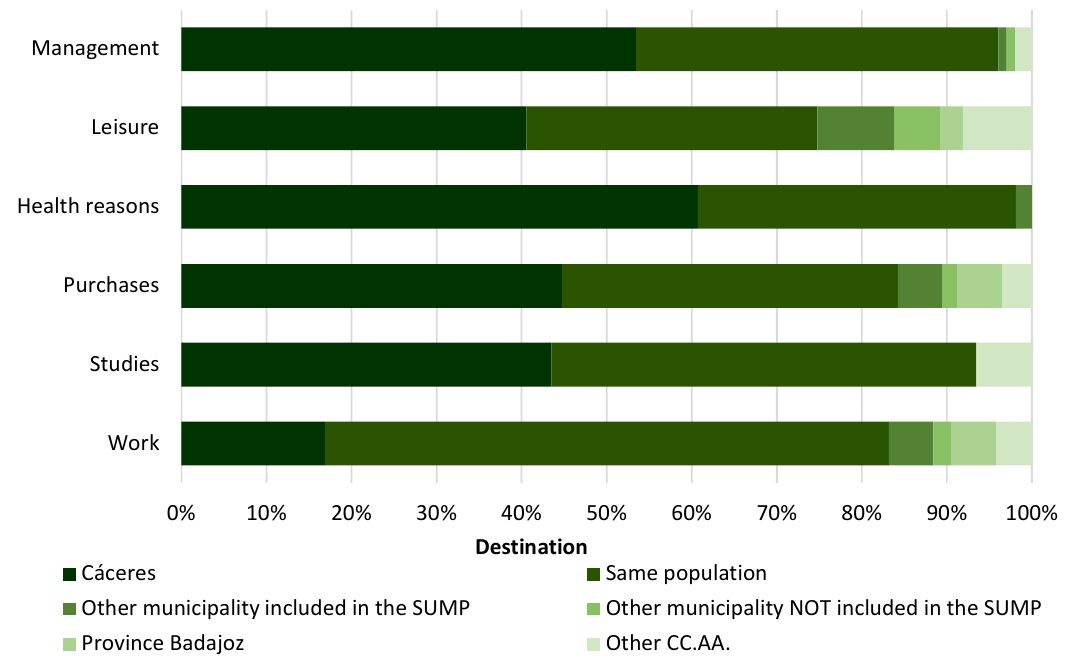
Figure 11. Destination of journeys of municipalities with a population of over 2000 inhabitants ac- cording to reason.